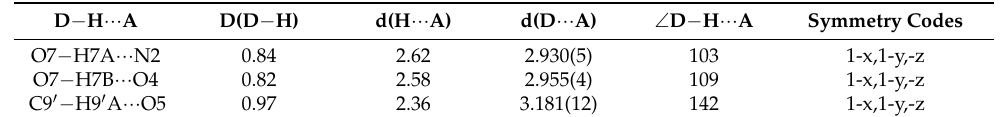
Table 4. Intramolecular hydrogen bonding data [Å, ◦ ] of the Cu II complex.